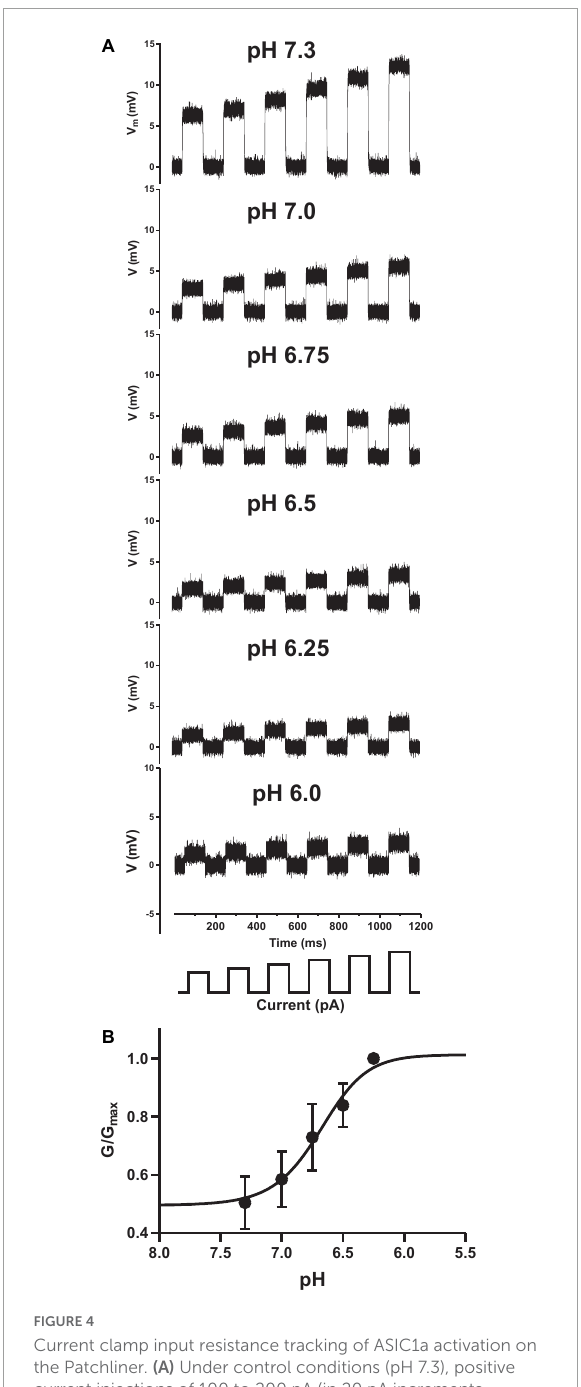
FIGURE4 Current clamp input resistance tracking of ASIC1a activation on the Patchliner. (A) Under control conditions (pH 7.3), positive current injections of 100 to 200 pA (in 20 pA increments, schematic at bottom) from a holding potential of 0 mV elicit membrane depolarizations. Input resistance in response to the same current injection protocol is gradually decreased after application of increasing pH solutions indicated in each panel. (B) Converting membrane resistance to conductance and normalizing the change in conductance for each pH concentration by the maximum conductance change (G/G max ) in each cell allowed plotting of the pH activation curve obtained under current clamp to yield an EC 50 value of 6.68 ± 0.01 (mean ± S.D, n =